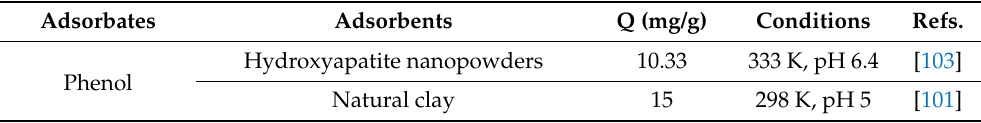
Table 3. Comparison of the adsorption capacities of nano HAp and its composites with other absorbents on organic